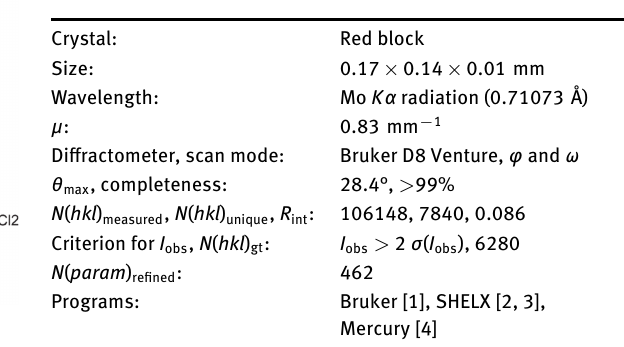
Table 1: Data collection and handling.